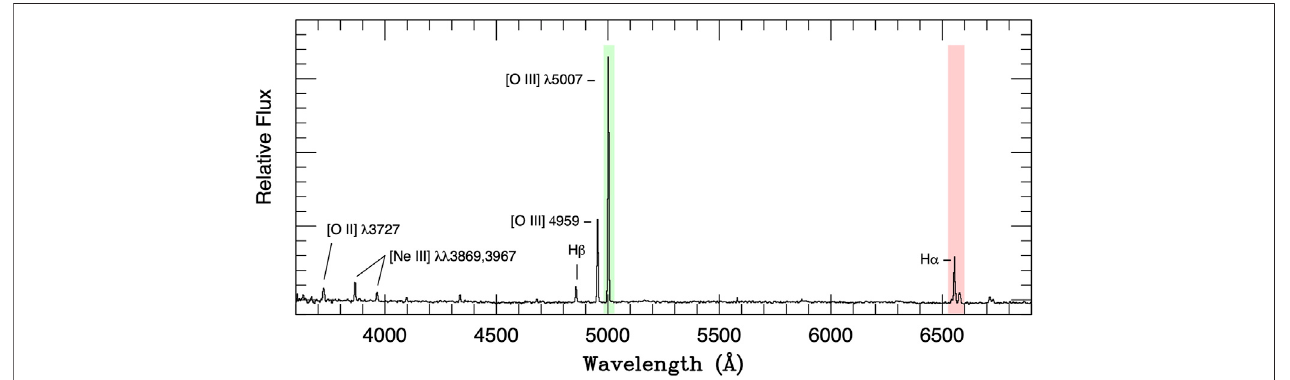
FIGURE1| The spectrum of M31 bulge PN CJFN 29, a typical object in the top ~ 1mag of the planetary nebula luminosity function. The PN is powered by a log L / L ⊙ = 3.66 central star and almost 6% of the core ’ s total energy emerges in [O III] λ 5007. The shaded areas represent the bandpasses of the interference fi lters used for the object ’ s detection. Note how much brighter [O III] λ 5007 is compared to H α and H β . From Jacoby and Ciardullo (1999).